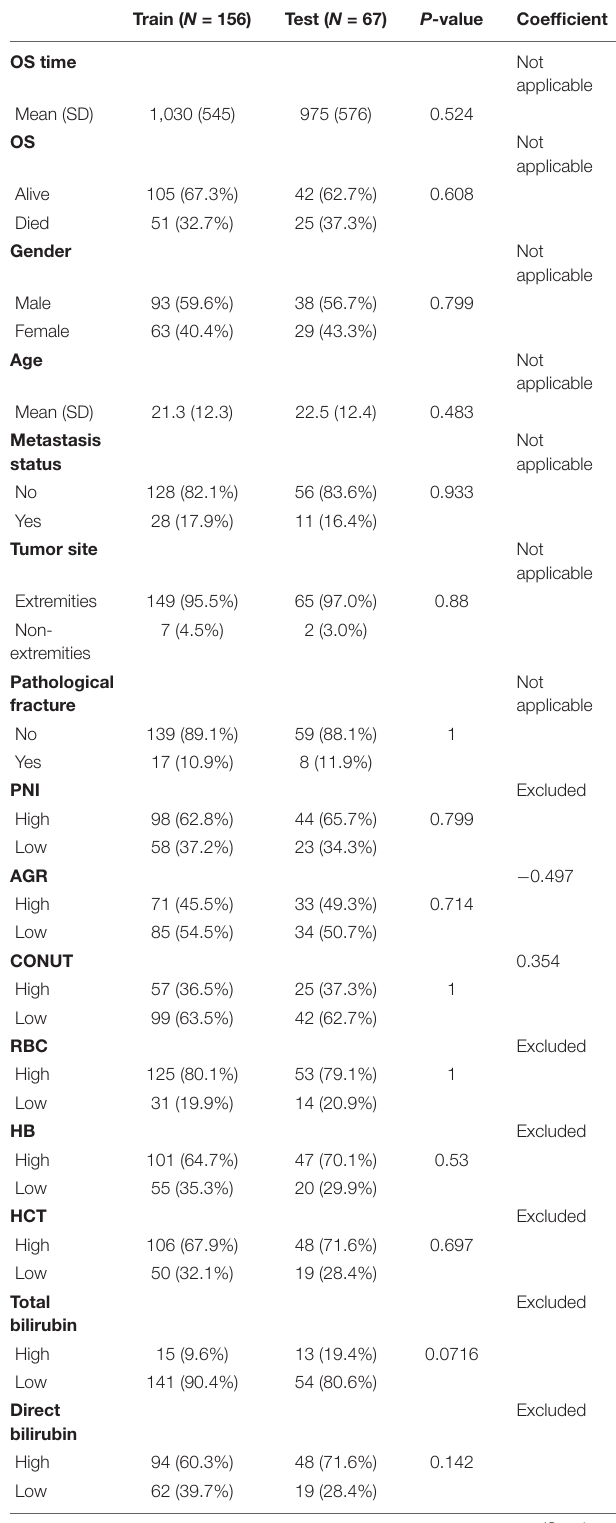
TABLE 1 | Differences in the distribution of all variables between the training set and the validation set and the respective coefficients of the 9 hematological markers that make up the